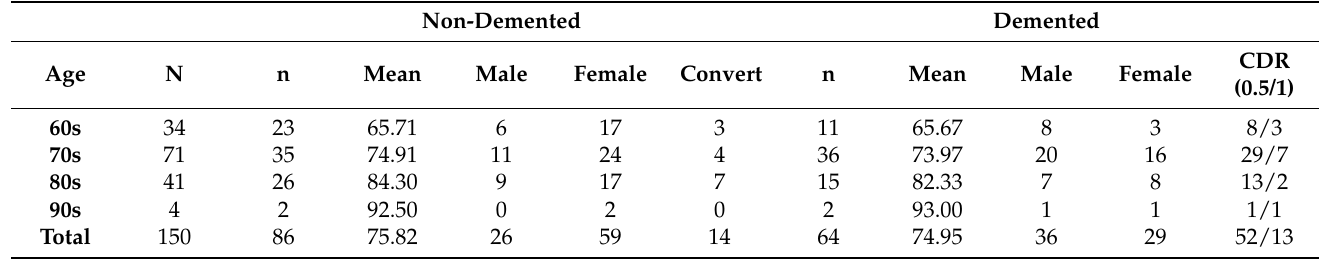
Table 2. Age and characteristics of the individuals investigated on the first clinical visit [18].